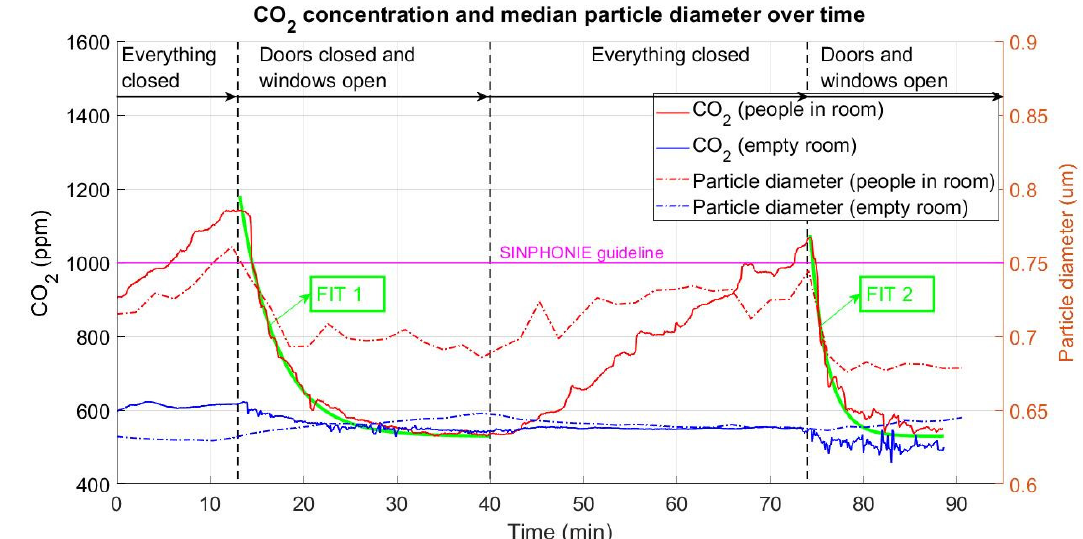
Figure 5. CO 2 concentration (ppm, continuous line) and particle median diameter (µm, discontinuous line). Red lines correspond to a populated room scenario (15 people). Blue lines correspond to the empty room scenario. First time stretch: closed room; second time stretch: windows open; third time stretch: closed room; fourth time stretch: windows and doors open.